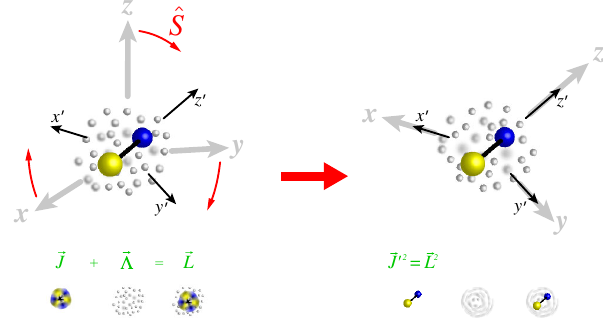
FIG. 1. Action of the canonical transformation, Eq. (4), on the many-body system. Left: In the laboratory frame, ð x; y; z Þ , the molecular angular momentum J combines with the bath angular momentum Λ to form the total angular momentum of the system L . Right: After the transformation, the bath degrees of freedom are transferred to the rotating frame of the molecule, ð x 0 ; y 0 ; z 0 Þ . As a result, the molecular angular momentum in the transformed space coincides with the total angular momentum of the system in the laboratory